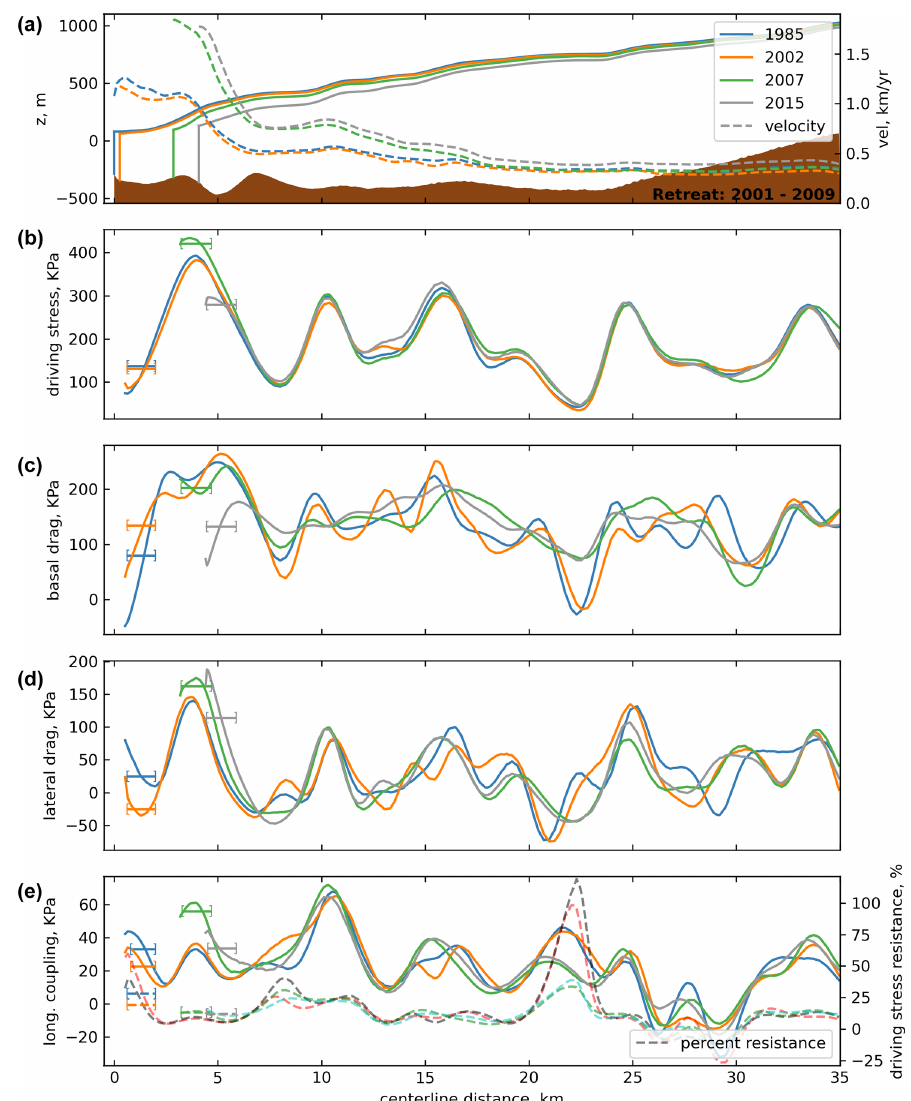
Figure 3. Time series of centerline dynamic components for Umiammakku Isbræ. Marked by the bracketed lines are the average values within one stress coupling length of the terminus at that time. (a) Surface and bed elevation profiles and along-flow velocity. Along-flow (b) driving stress, (c) basal drag, (d) lateral drag, and (e) longitudinal coupling and percentage of driving stress supported by longitudinal coupling. Positive values of driving stress act in the direction of flow; positive values of all other stresses oppose